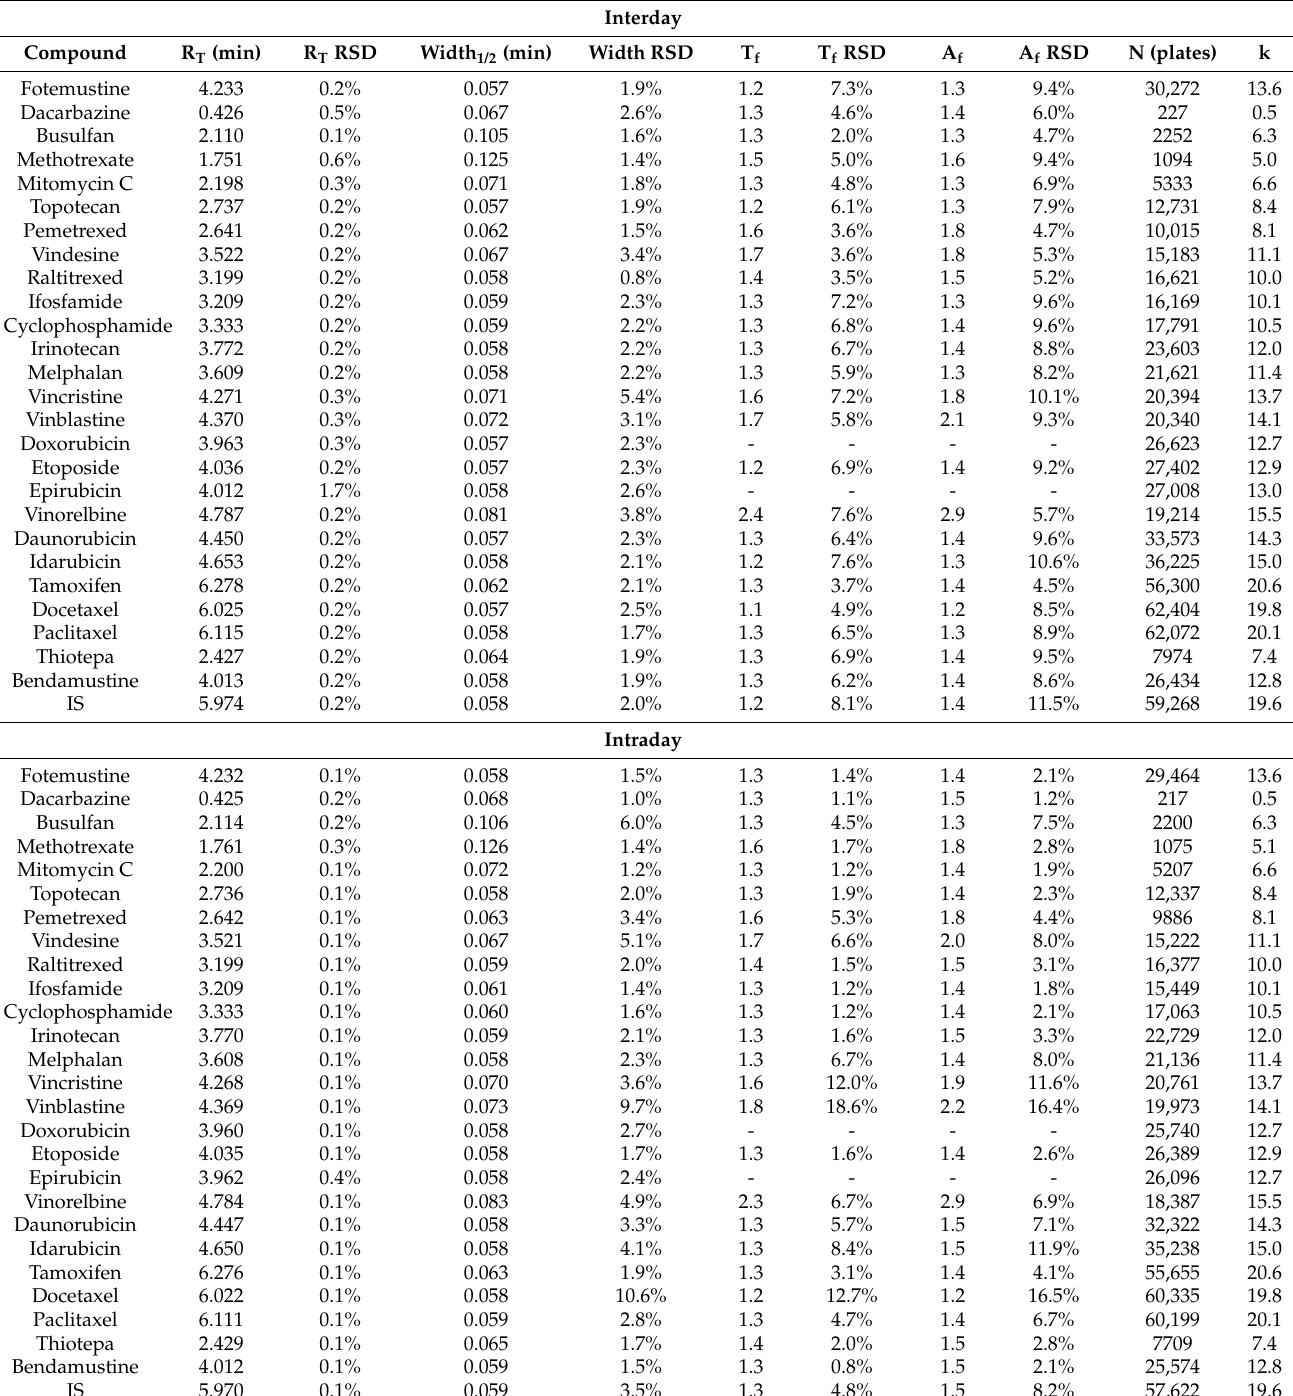
Table 4. The analytes’ retention times (R T ), peak widths (Width 1/2 ), tailing factors (5%) (T f ), asymmetry factors (10%) (A f ), and their relative standard deviations (RSD), calculated plate numbers (N), and retention factors